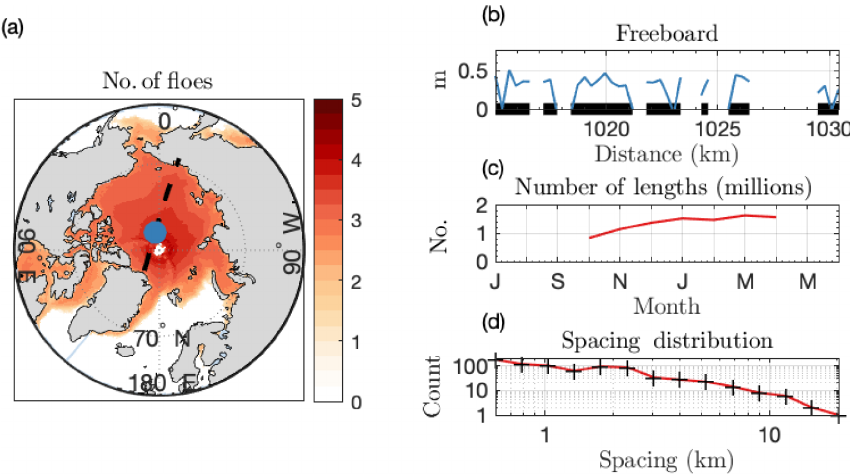
Figure 2. Constructing a FCD from altimetry. (a) Base 10 logarithm of the number of floe chords identified and binned into the CESM grid, across all CryoSat returns in the Arctic from 2010 to 2018. Black line is a single satellite track on 21 January 2014. (b) Subsection of the track centered on the blue dot in (a) . Blue line is freeboard of sea ice in radar echoes defined as “floes” along the track. Black lines are chords identified from the freeboard retrieval. (c) Total number of chords measured in each month in the Arctic. Plot is centered on 1 January. (d) FCD for the satellite track depicted in (a) . Black marks on the x axis are the logarithmically spaced chord length